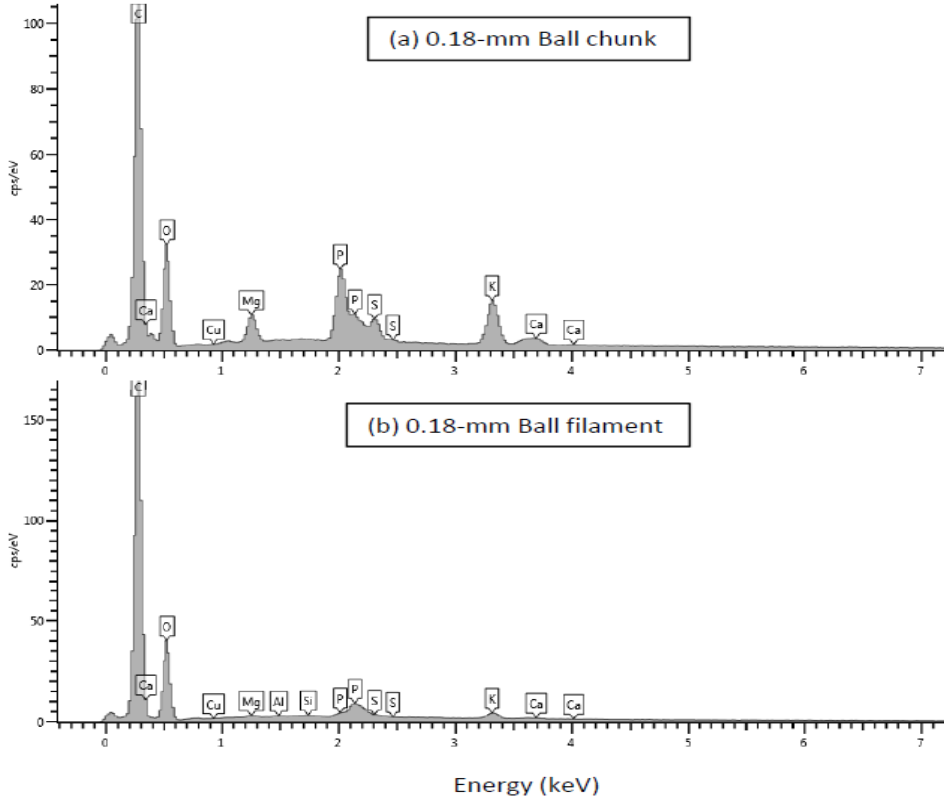
Figure 3. EDS spectrograms of the chunk and filament particles of WCSM products ground by the ball mill and passed by a 0.18-mm screen.